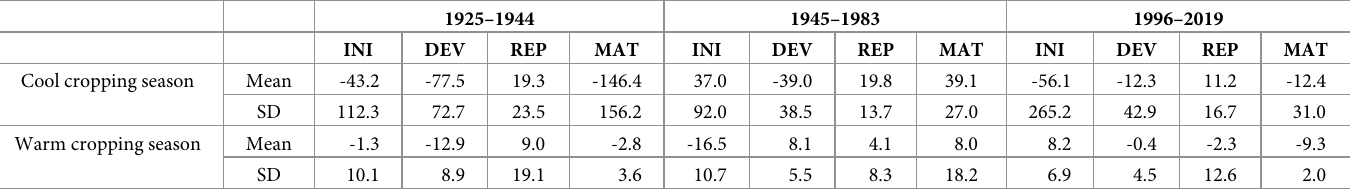
Table 1. Total rice yield change (kg ha -1 ) related to crop water status over the periods 1925–1944, 1945–1983, and 1996–2019 under initial (INI), crop development (DEV), reproductive (REP), and maturity (MAT) stages in the cool and warm cropping